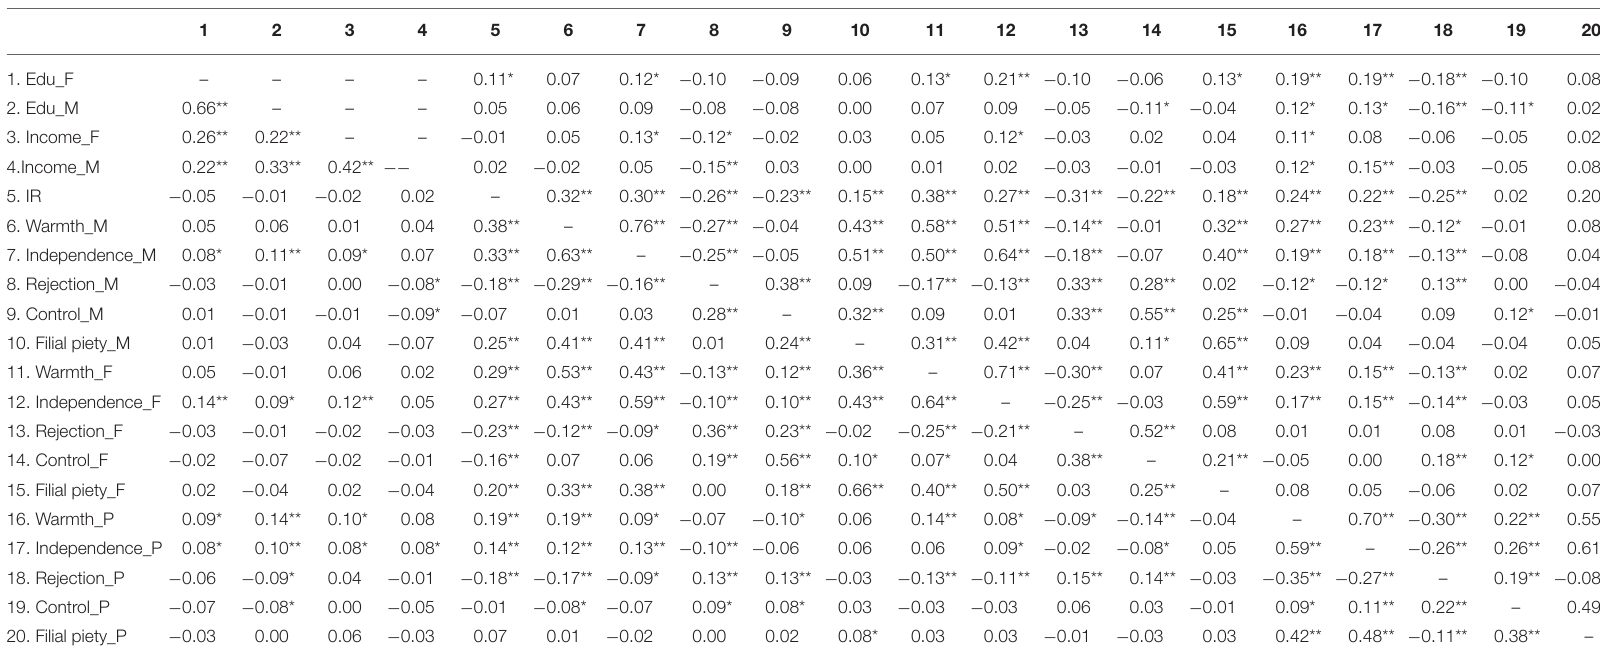
TABLE 2 | Zero-order correlations among the research